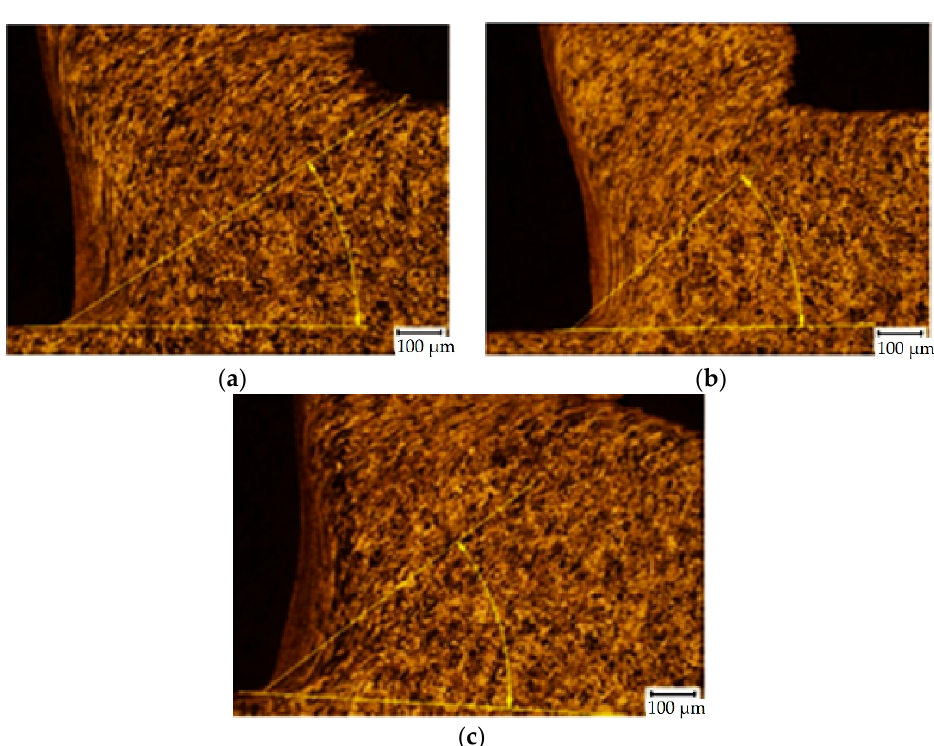
Figure 8. Examples of SEM micrographs of the cutting zone (C45 medium carbon steel, v c = 180 m/min): ( a ) specimen no. 7 ( f = 0.2 mm), ϕ = 37°; ( b ) specimen no. 8 ( f = 0.4 mm), ϕ = 39°; ( c ) specimen no. 9 ( f = 0.6 mm), ϕ = 49°.